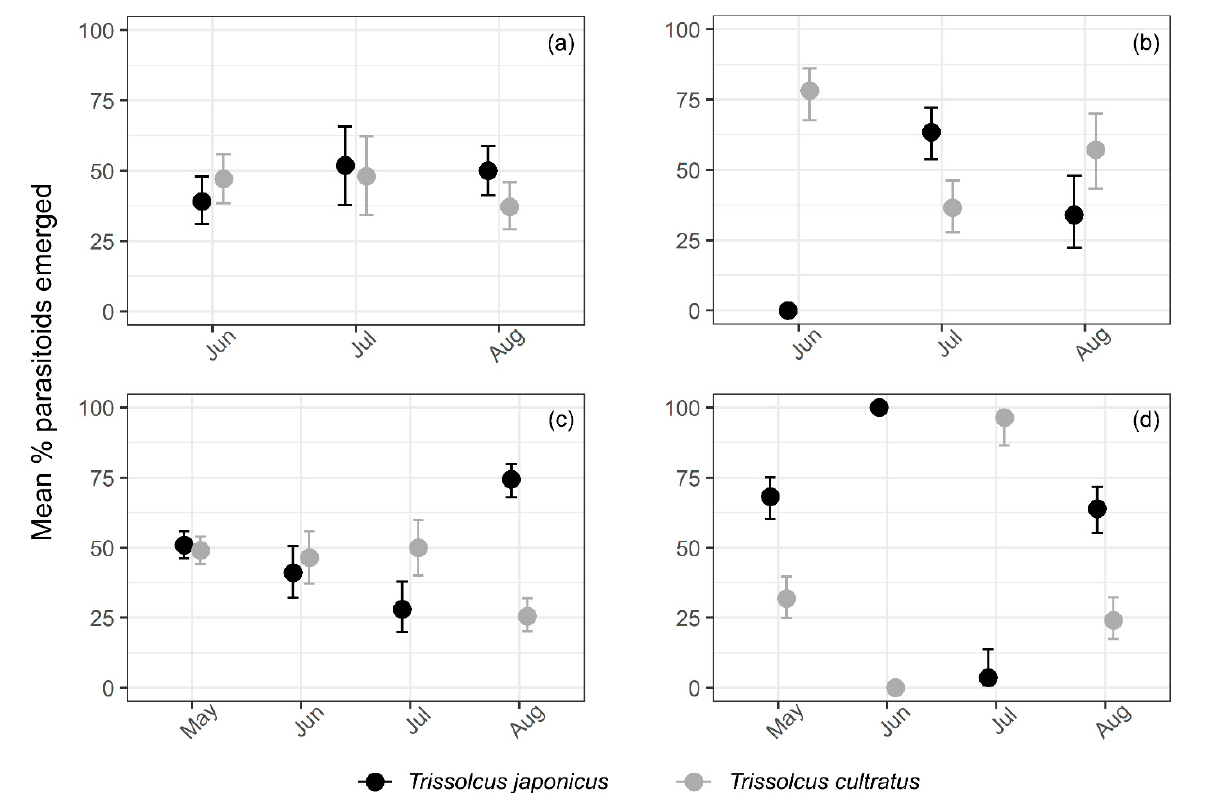
Figure 4. Estimated mean abundance of Trissolcus japonicus and T. cultratus (with 95% confidence intervals) recovered from successfully parasitised sentinel Halyomorpha halys egg masses in Mei County, Shaanxi Province, China during egg parasitoid surveys in kiwifruit in: ( a ) 2018 organic orchard, ( b ) 2018 conventional orchard, ( c ) 2019 organic orchard, and ( d ) 2019 conventional orchard. The circles are the back-transformed predicted means by the generalised linear model (GLM) model and the vertical lines show back-transformed confidence intervals. Non-overlapping confidence intervals within each species suggest evidence of statistically significant difference.